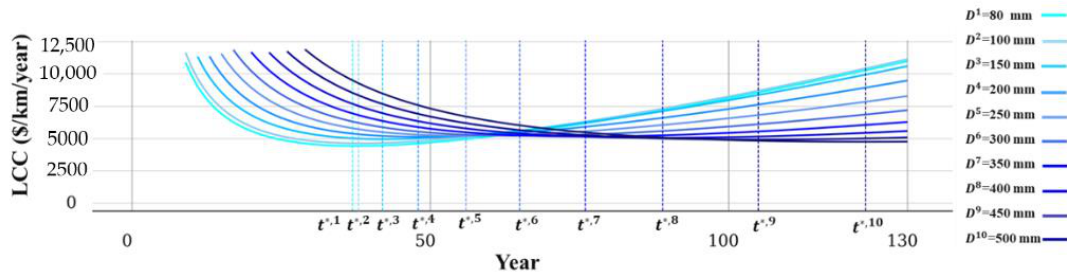
Figure 6. Optimal replacement time ( t ∗ ) for each pipe diameter based on LCC